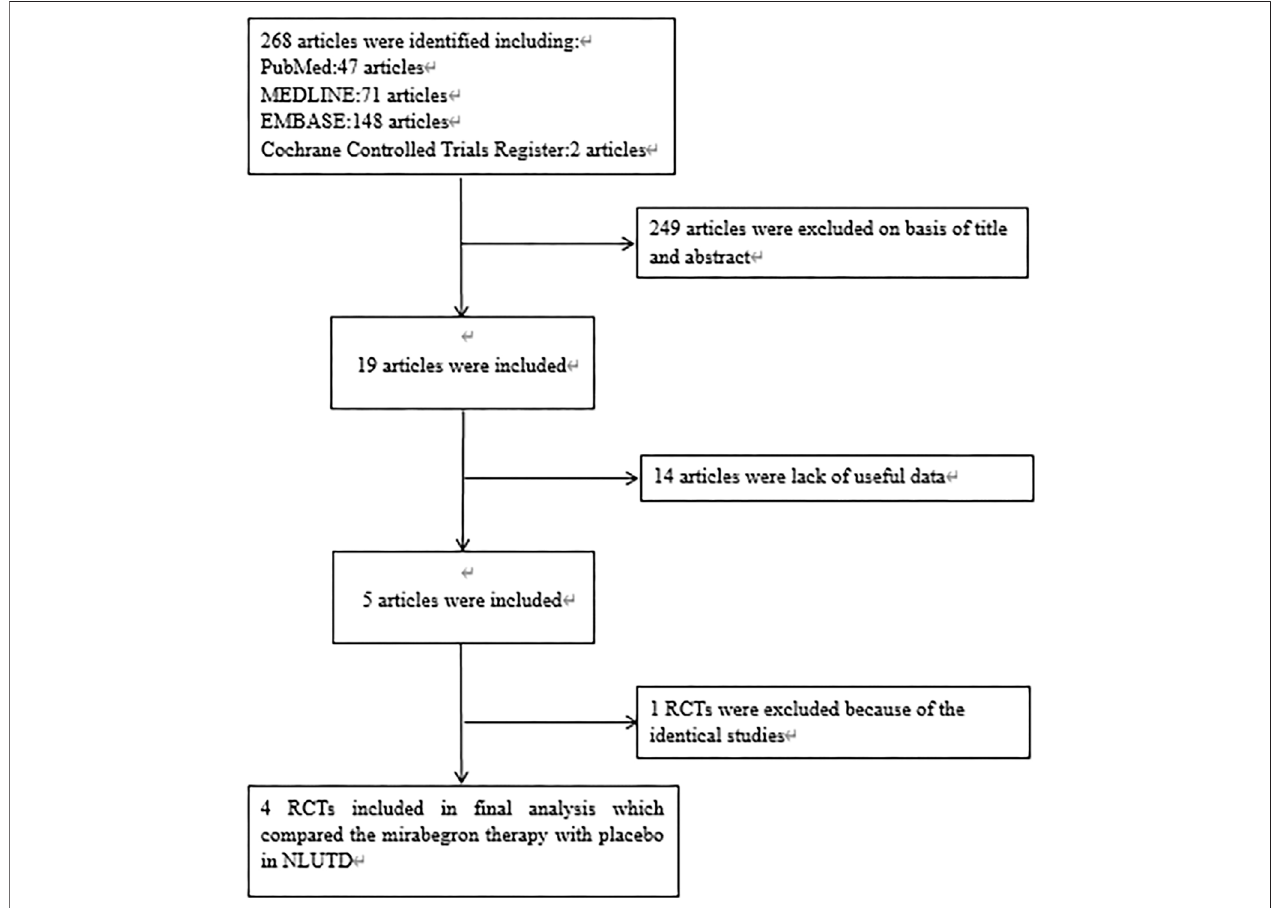
FIGURE 1 | Flowchart of the study selection process. RCT, randomized controlled trials; NLUTD, neurogenic lower urinary tract dysfunction.